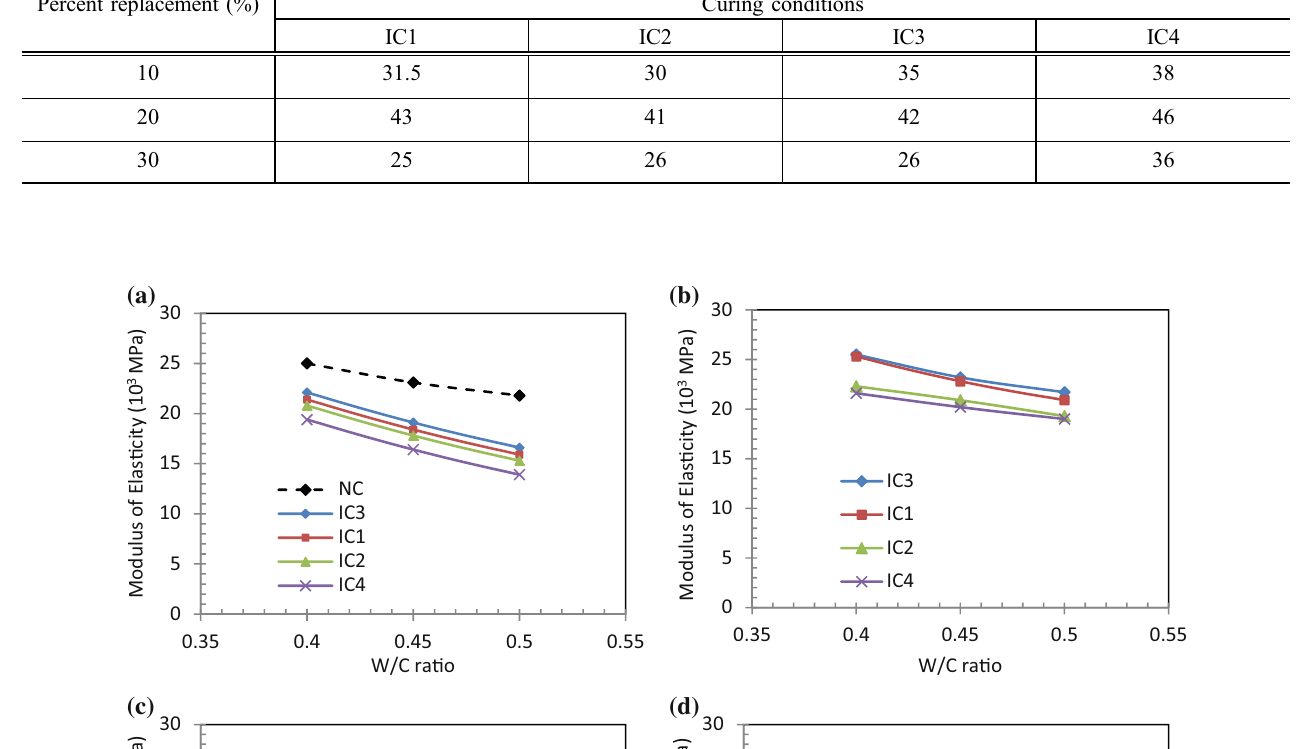
Table 3 Percent increase in compressive strength with respect to control samples under similar curing conditions (w/c ratio 0.4). Percent replacement (%)